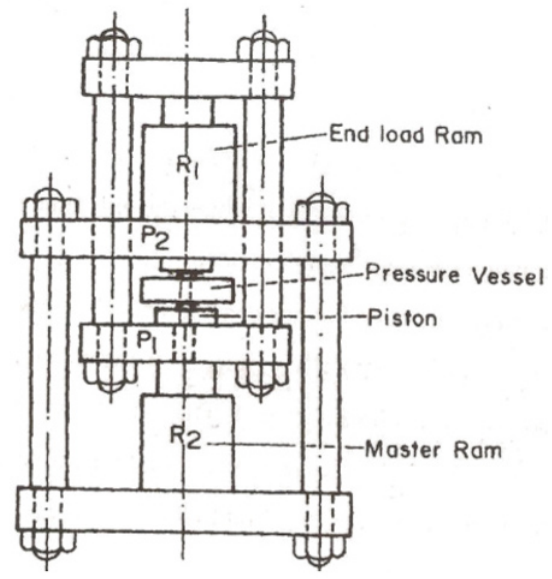
. Piston-cylinder apparatus.